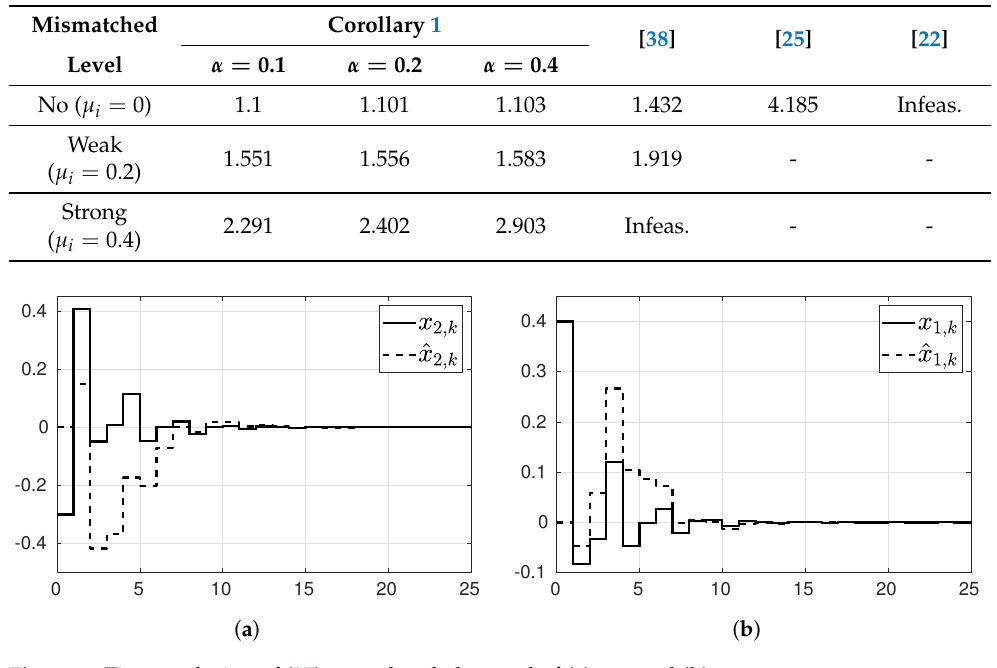
Figure 1. Time evolution of (37): actual and observed of ( a ) x 2, k and ( b ) x 1, k